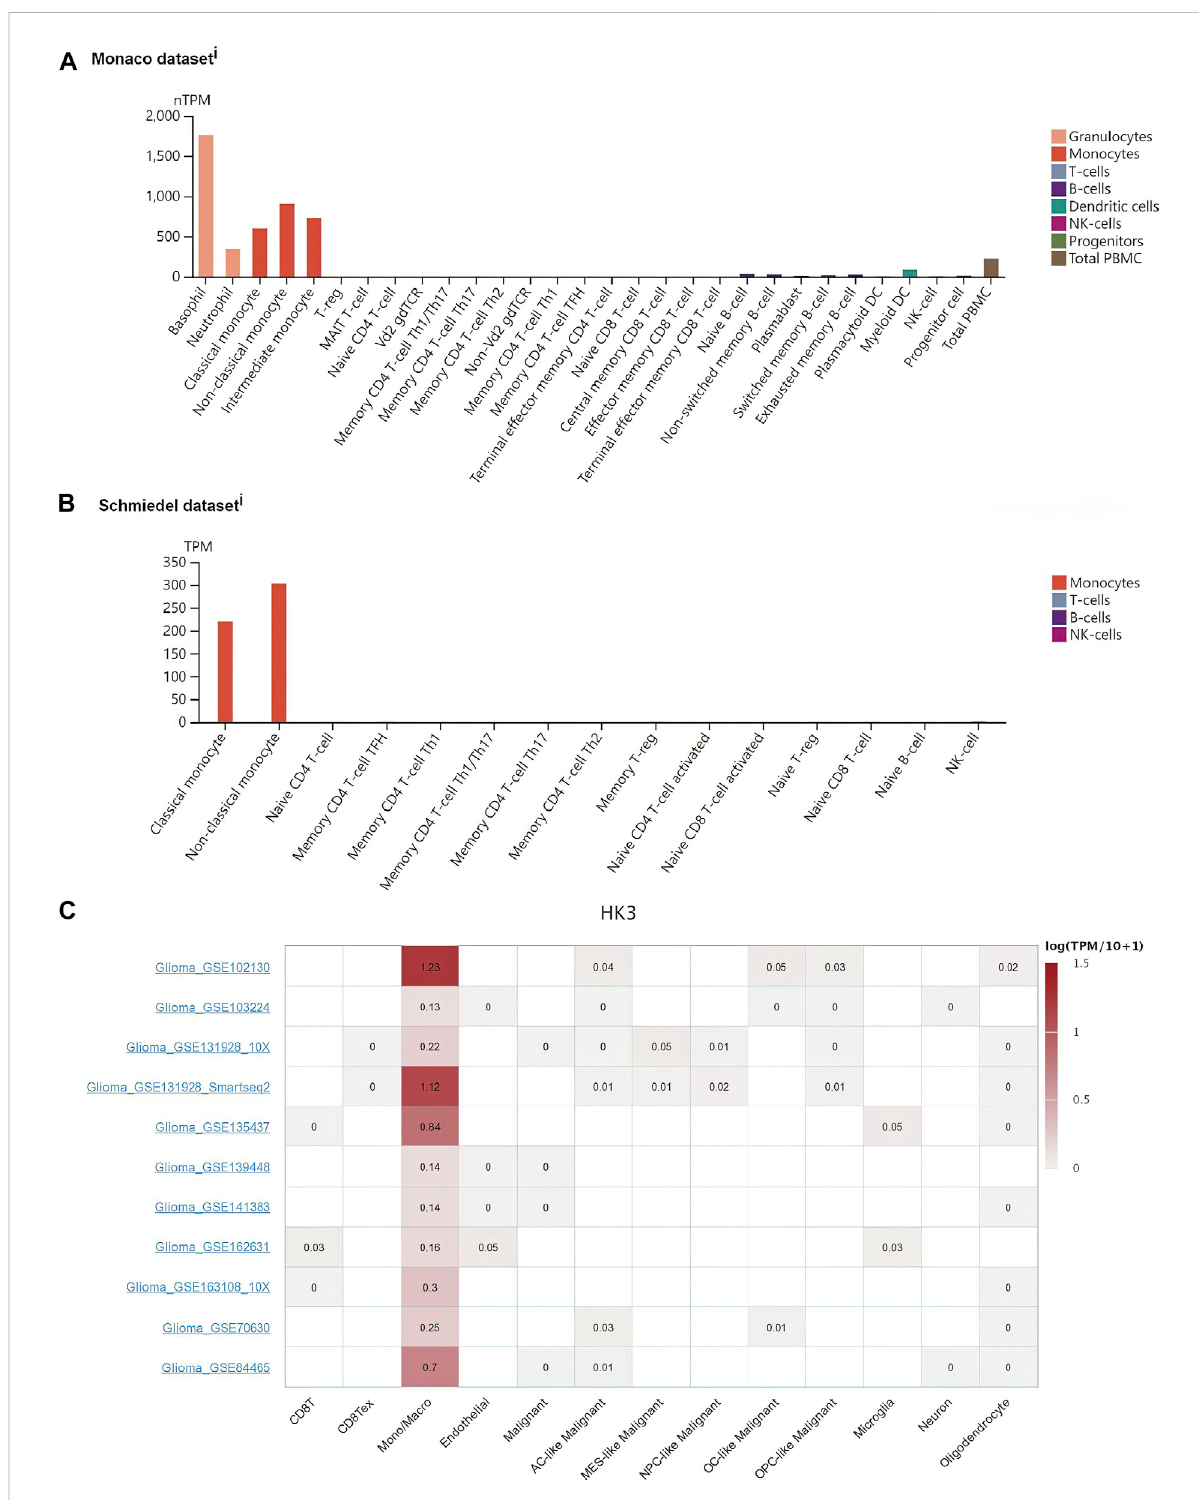
FIGURE 6 Association of HK3 expression with macrophages. HK3 expression in macrophages in the Monaco dataset (A) and Schmiedel dataset (B) . (C) HK3 expression in immune cells in GBM via the TISCH